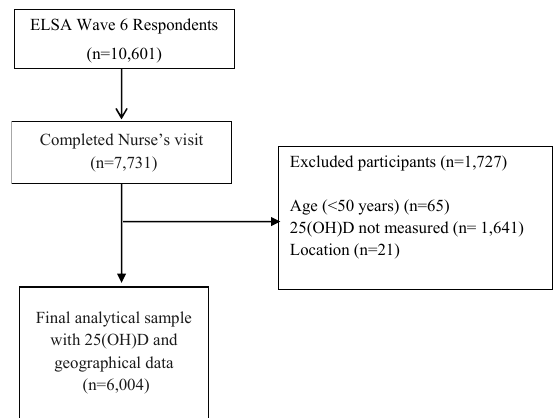
Figure 1. Study design. ELSA, English Longitudinal Study of Ageing.